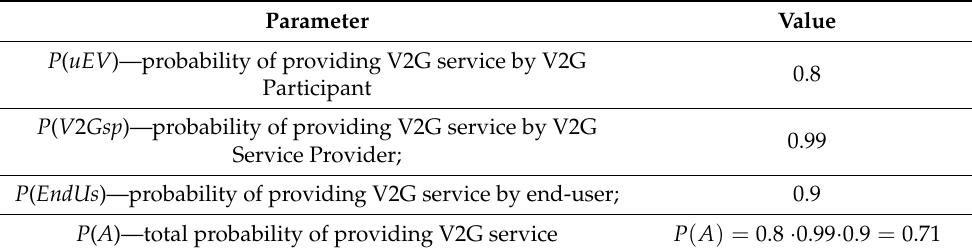
Table 4. Probabilities used in simulation of the proposed algorithm. Parameter